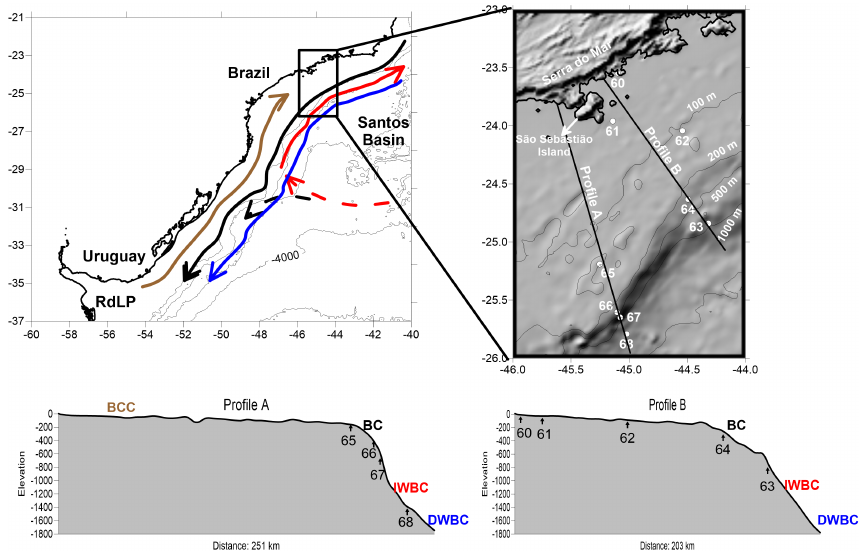
Figure 1. Location of the south-western Atlantic margin with a zoom to the study area and sampling stations. RdLP refers to Rio de La Plata. Arrows refer to the main current systems in the area: Brazilian Coastal Current (BCC) – brown; Brazil Current (BC) – black; Intermediate Western Boundary Current (IWBC) – red; Deep Western Boundary Current (DWBC) – blue. The dashed line corresponds to the approximate position of the Santos Bifurcation (Boebel et al.,